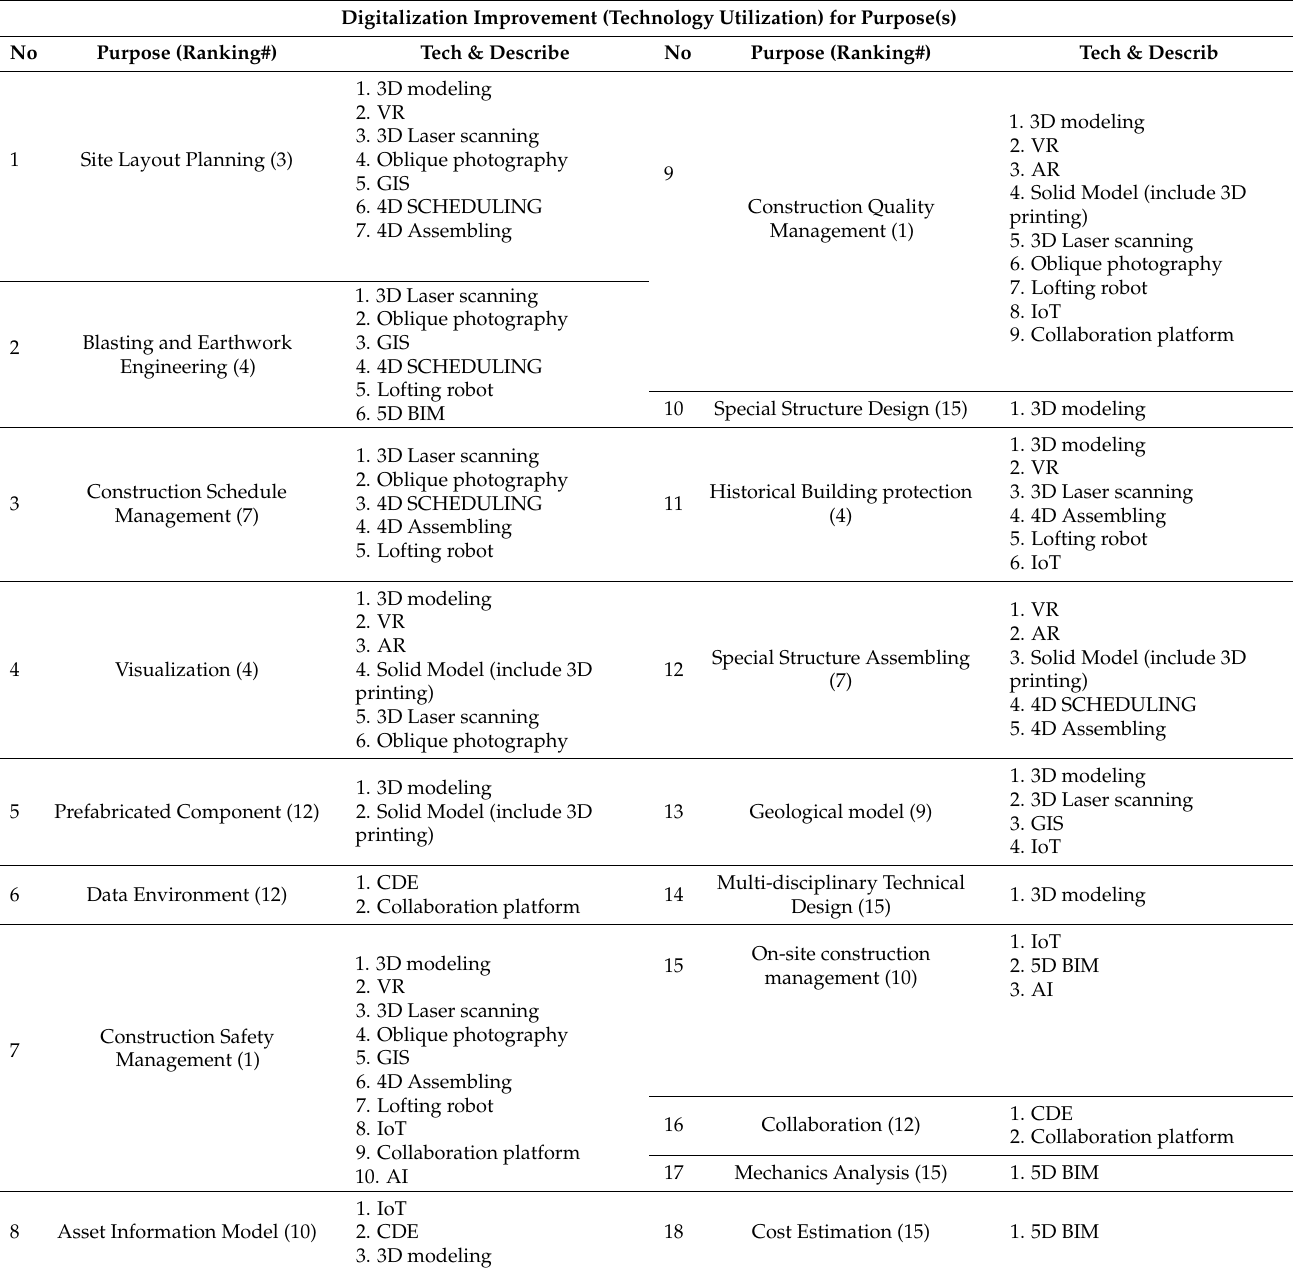
Table 8. Digitalization improvement (technology utilization) for particular